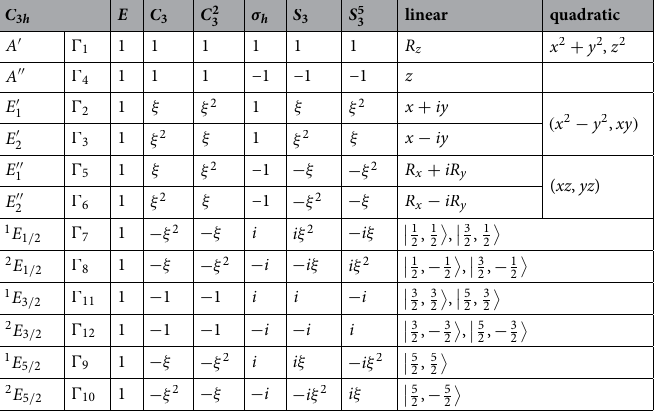
Table 1. Character table of the group C 3 h with ξ 3 of the single and double group. The reduction of symmetry from D 3 h to C 3 h is accompanied by the compatibility relations A ′ 1 , A ′ 2 1 E 2 E E 3 / 2 3 / 2 (cid:31) 3 / 2 , and →